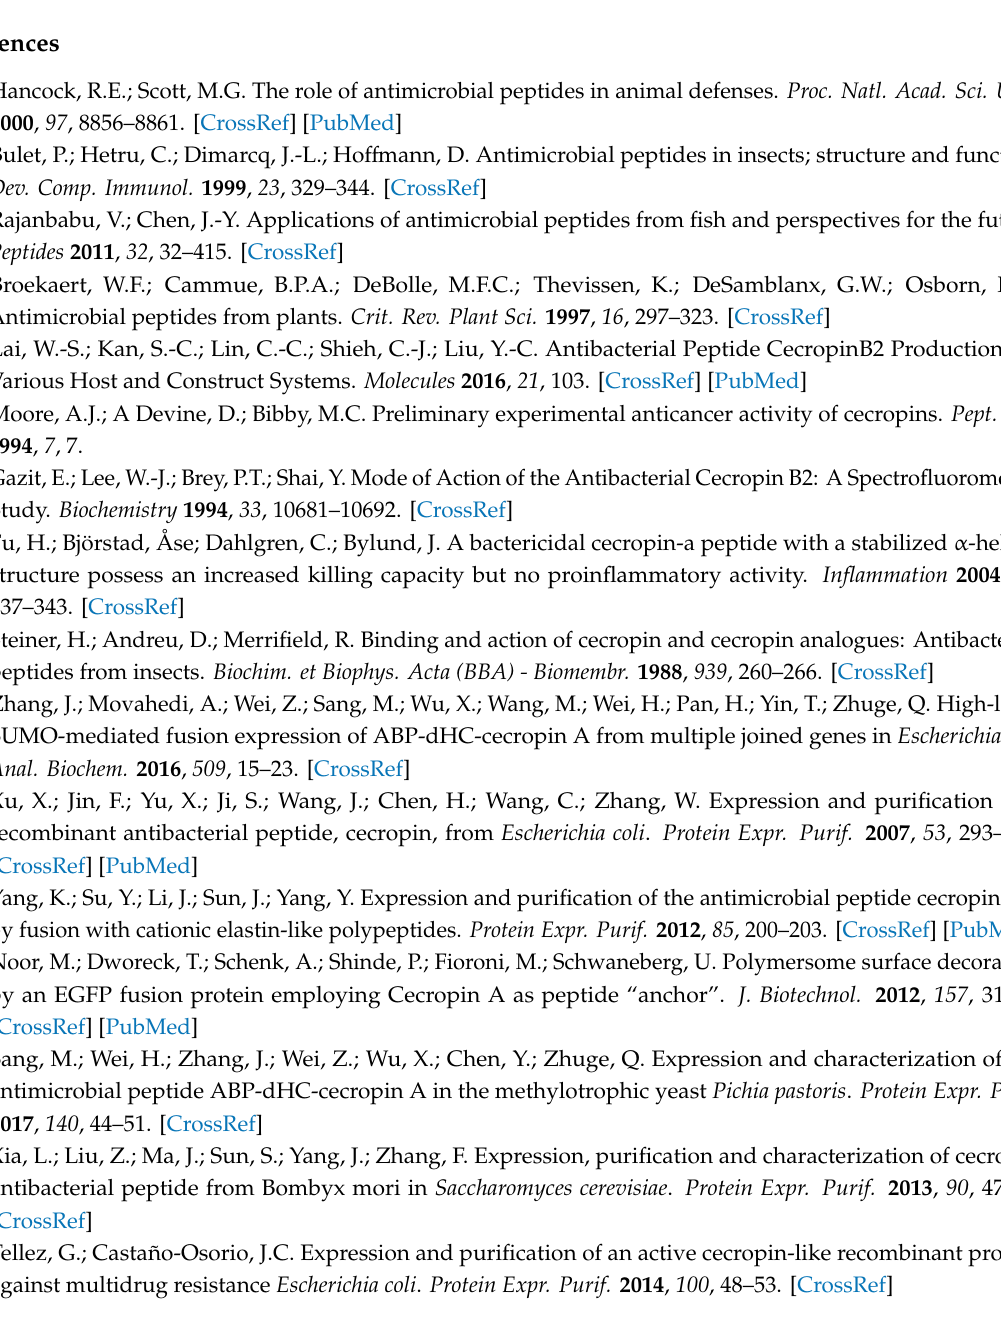
s1, Figure S1: Predicted structure of CBD-INT-CecB2 fusion protein. Figure S2: The quality assessment of CBD-INT-CecB2 fusion protein. Table S1: Abbreviation